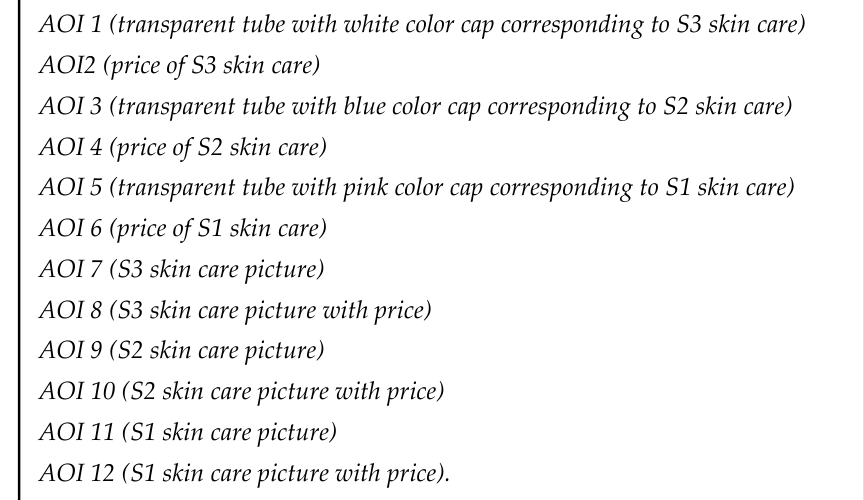
Figure 5. Areas of interest (AOIs) definitions. Source: the authors (2020).